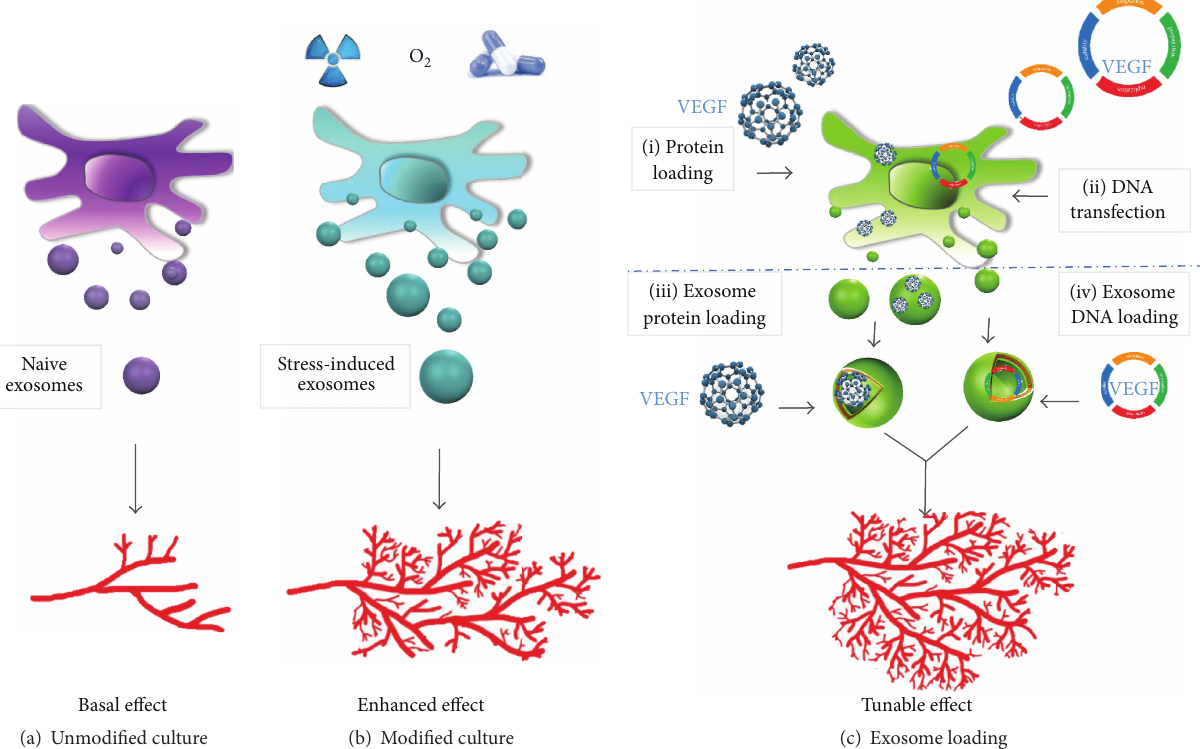
Figure 1: Different possible strategies to enhance the angiogenic potential of exosomes released by stem cells. (a) Stem cells cultured under normal culture condition constitutively produce exosomes with a basal angiogenic potential. (b) Specific in vitro stress conditions mimicking organ injury situations, such as hypoxia, irradiation, or drug treatments, induce changes in exosomal RNA and protein repertoire. These alterations of exosomal composition are thought to facilitate angiogenesis and tissue repair through an enhanced level of growth factors and cytokines. (c) The transfection of exosomes producer cells with protein or DNA encoding therapeutically active angiogenic compounds which arethenreleasedwithinthereleasedexosomesconstitutesanotherapproach.Sinceoverexpressionofaspecificfactordoesnotensureasimilar increase of its representation in the exosome cargo, another strategy is to directly load the exosomes after release with proangiogenic factors such as the recombinant VEGF protein or the vector encoding its expression. Hence, boosting the exosome with proangiogenic factors can be achieved directly or indirectly, and each approach has its advantages and limitations and may be dictated by the type of the encapsulated molecule (molecular weight, posttranslational modifications) and conditions suitable for a specific type of exosome-encapsulated